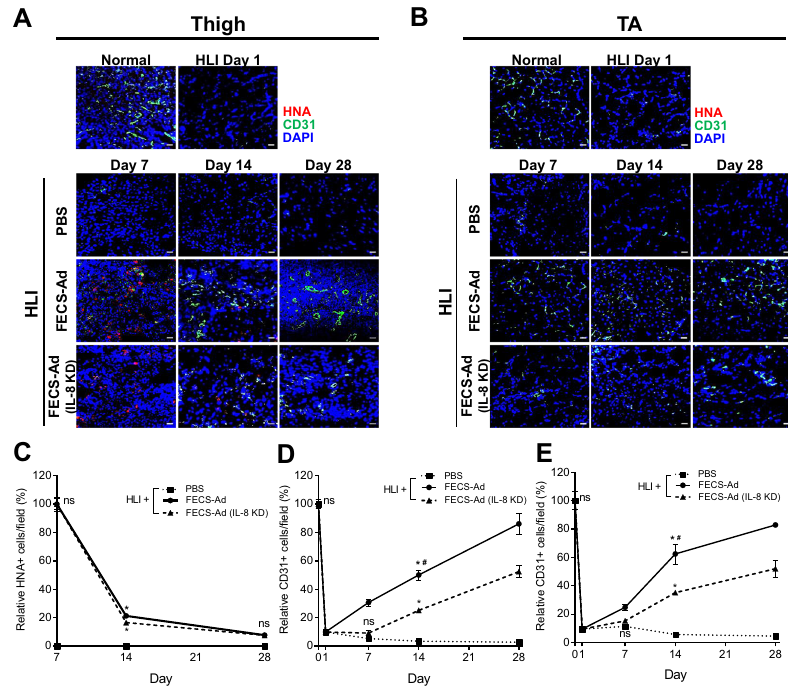
Fig. 8 Roles of IL-8 in the angiogenesis of FECS-Ad in mouse hindlimb ischemia. Ischemic thigh and TA muscles isolated from PBS, FECS-Ad, or IL-8-silenced FECS-Ad-injected mice were immunostained with HNA and CD31. Nuclei were stained with DAPI. HNA and CD31 staining of A ischemic thigh and B TA of each group at 1, 7, 14, and 28 days post-surgery. n = 5 per group. Scale bar, 20 μ m. C Ratio of HNA-positive cells in ischemic thigh. FECS-Ad group at day 7 was presented as 100%. ns not signi fi cant between FECS-Ad and FECS-Ad (IL-8 KD) group, * p < 0.0001 compared to PBS group (two-way ANOVA). n = 5 per group. Percentage of CD31-positive cells in D ischemic thigh and E TA. Normal group was presented as 100%. ns not signi fi cant between PBS and FECS-Ad group, * p < 0.0001 compared to PBS group, # p < 0.0001 compared to FECS- Ad (IL-8 KD) group (two-way ANOVA). n = 5 per group. All data are presented as mean ±